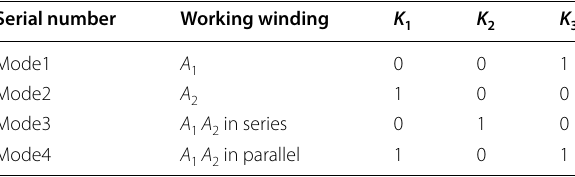
Table 4 On-off state of change-over switch Serial number